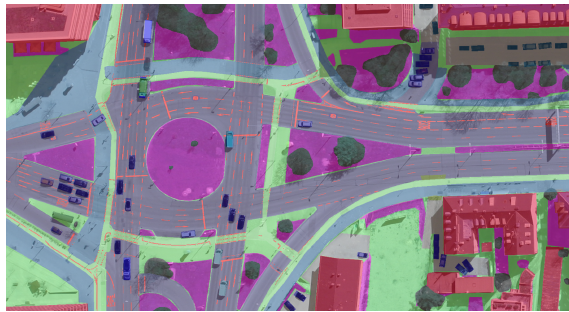
Figure 9. Example of pixel-wise annotations with 22 classes containing both static and non-static objects.